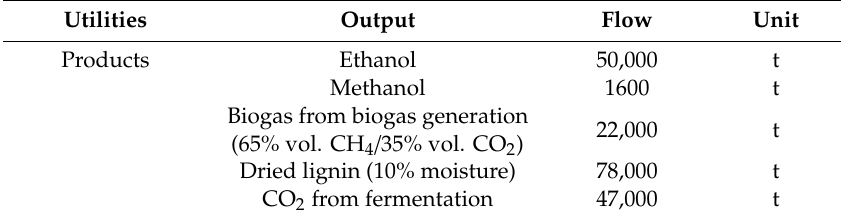
Table A3. Detailed description of product output per year